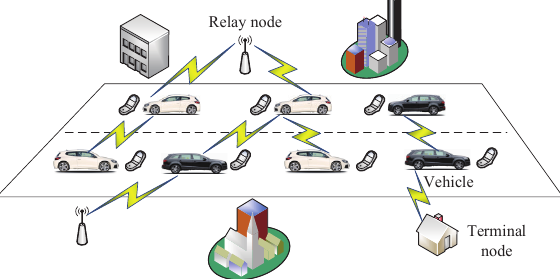
Figure 19. The model of vehicular delay-tolerant